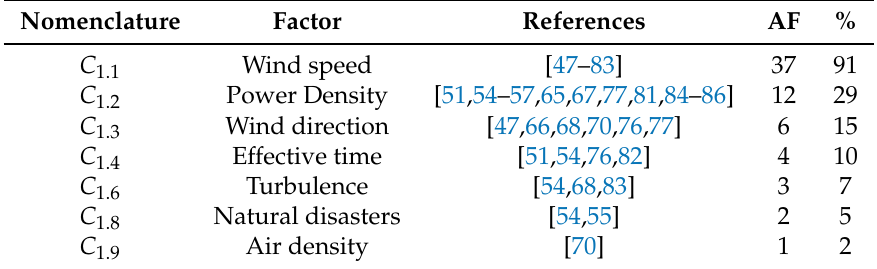
Table 13. Climate Category ( C 1 )—Offshore wind energy. Quantitative